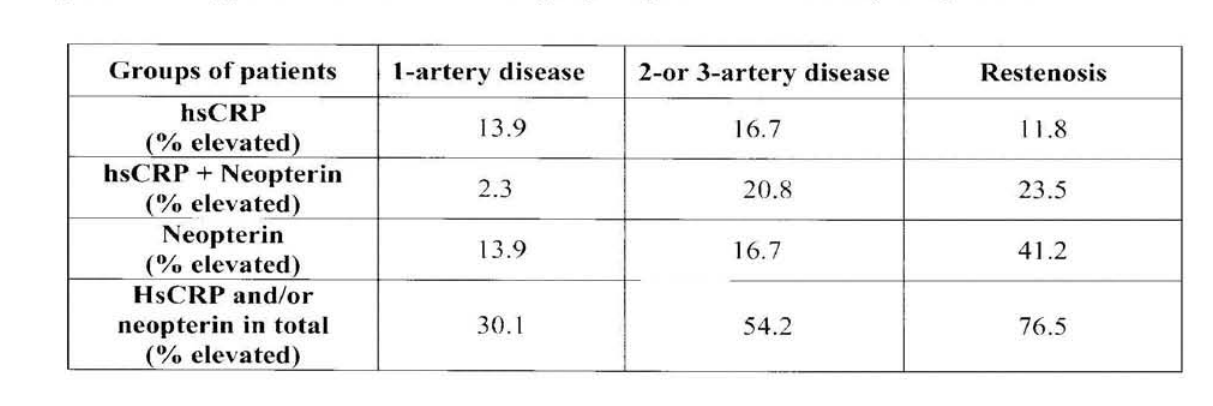
Table I. Percentage of cases with increased concentrations of high sensitivity C-reactive protein (hsCRP) and/or ncoptcrin above upper normal limit in different groups of patients with coronary artery disease.